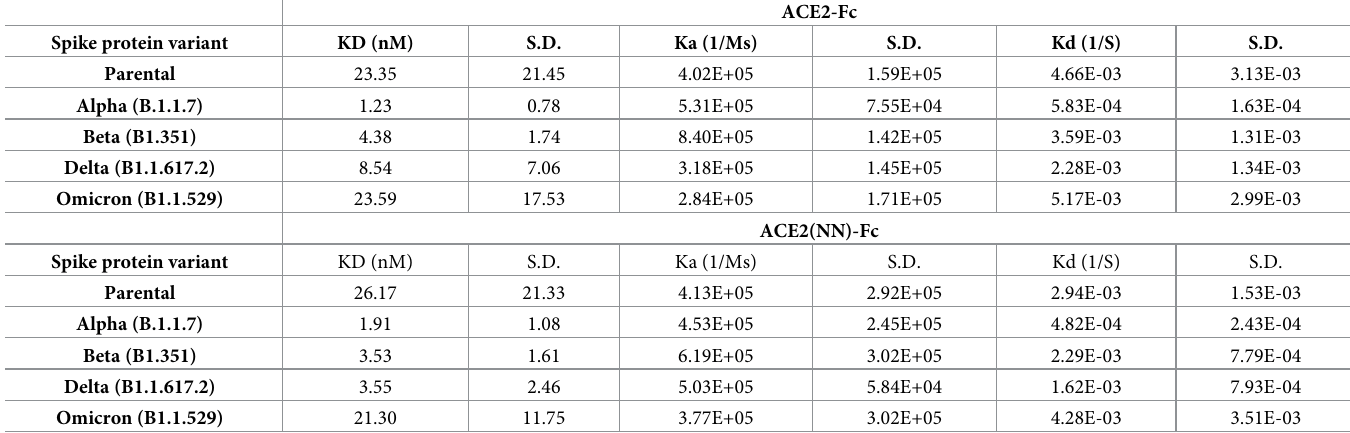
Table 1. Average ACE2-Fc and ACE2(NN)-Fc binding affinity, association rates, and dissociation rates with different spike protein